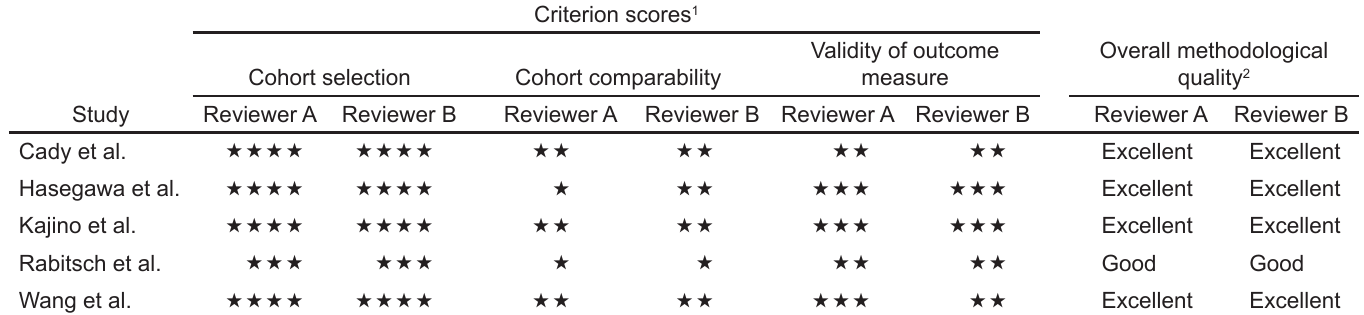
Table 2. Summary of criterion scores and overall methodological quality (reviewers A and B) for five included studies comparing